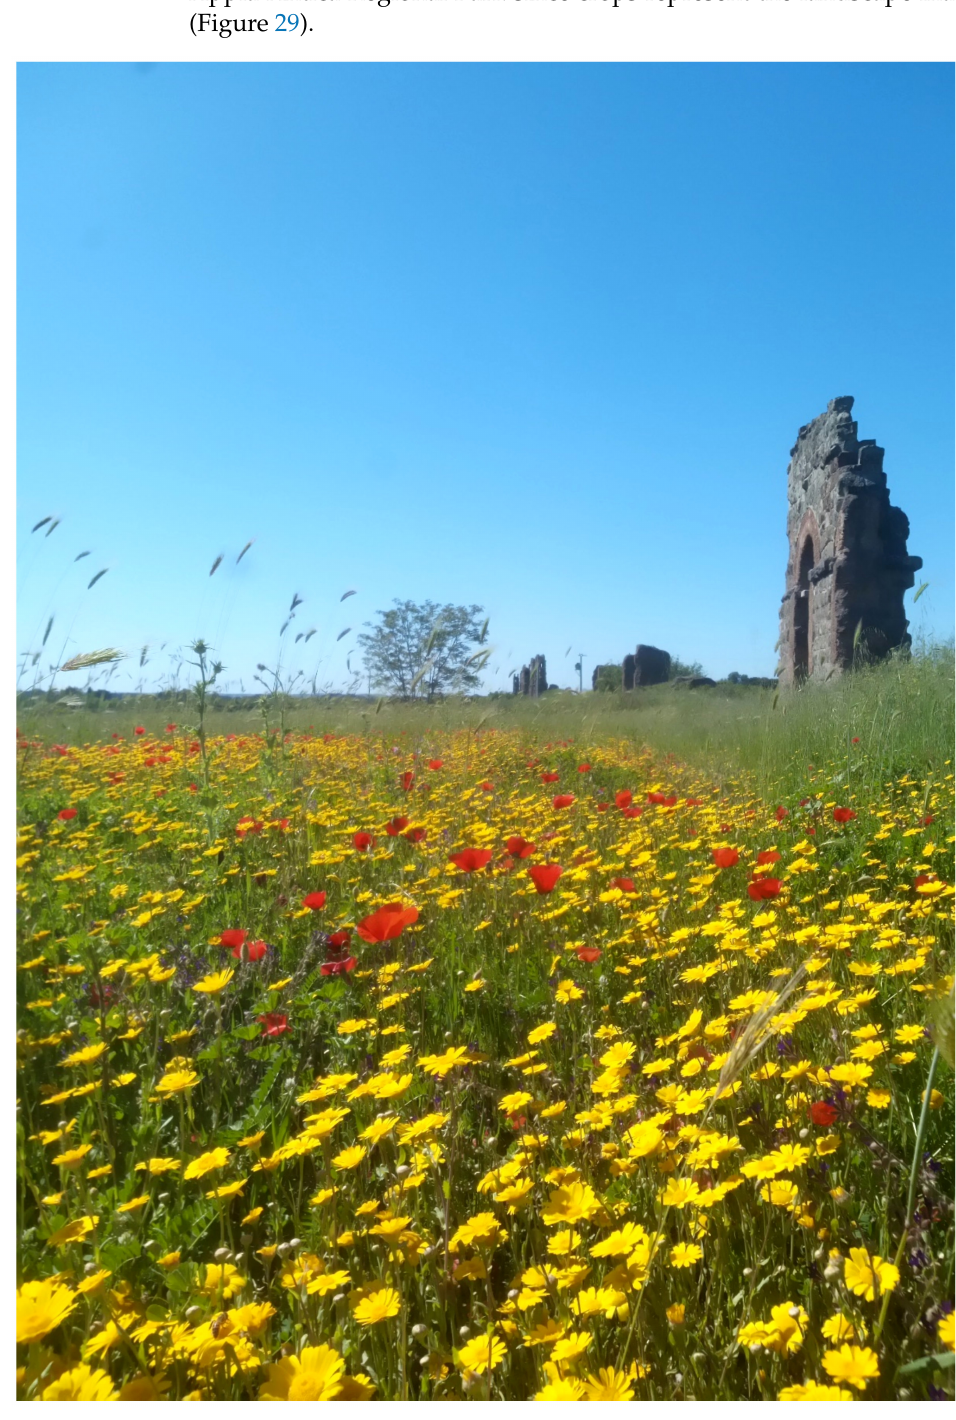
Figure 29. Segetal vegetation dominated by Glebionis segetum (L.) Fourr. and Papaver rhoeas L., Papaveretea rhoeadis (Acquedotty